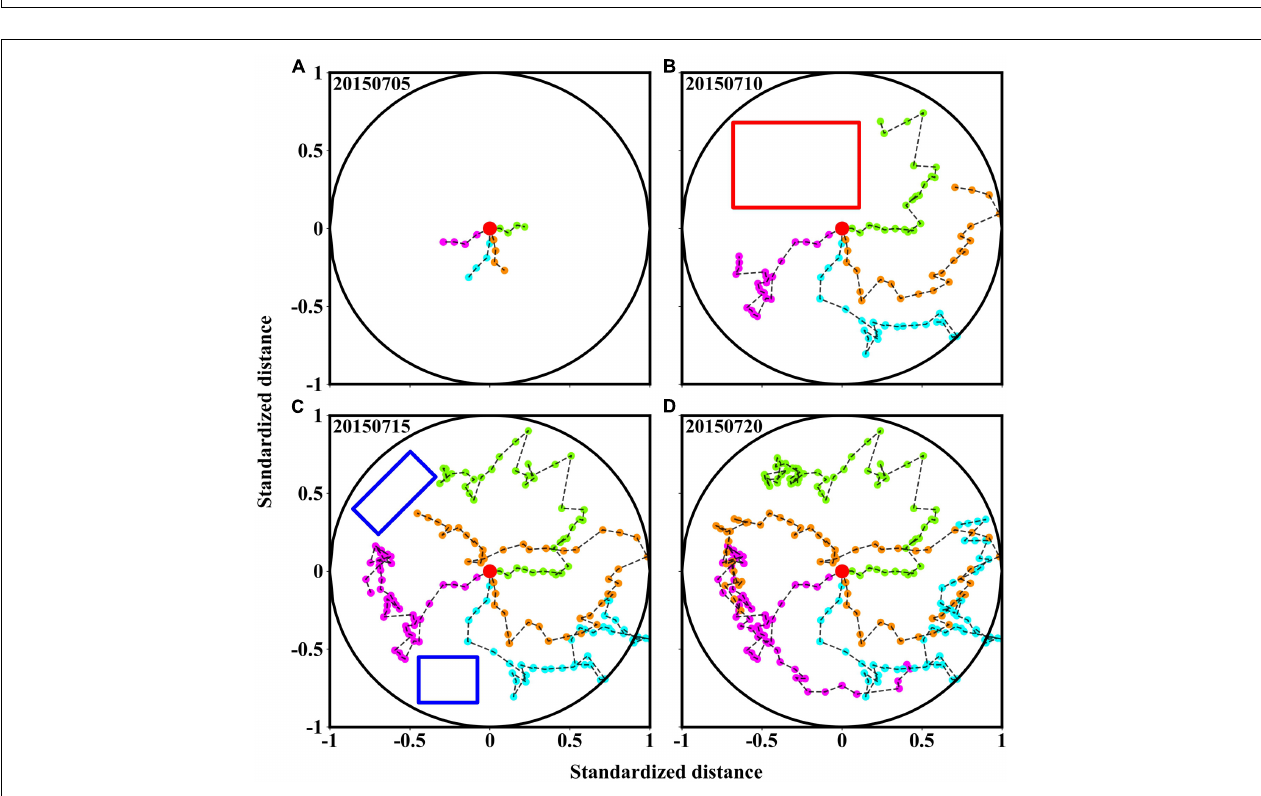
Frontiers in Marine Science |